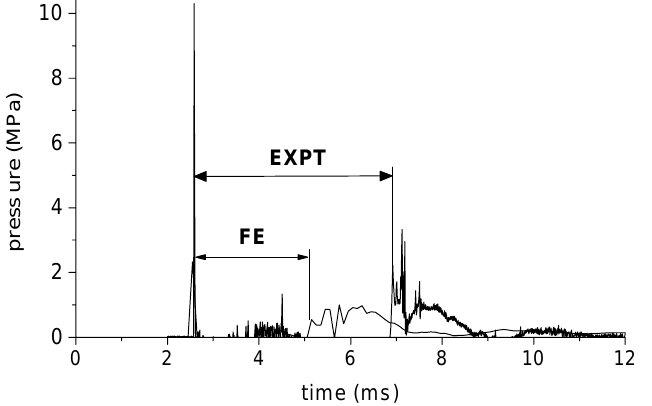
Fig. 6. Comparison of cavitation duration for the finite element model (simulation #4) and the related experimental data from event 8 (EXPT) adjacent to the test plate centre (pressure gauge: P2). The cavitation closure for the finite element model occurs almost 2 ms earlier than for the experiment.